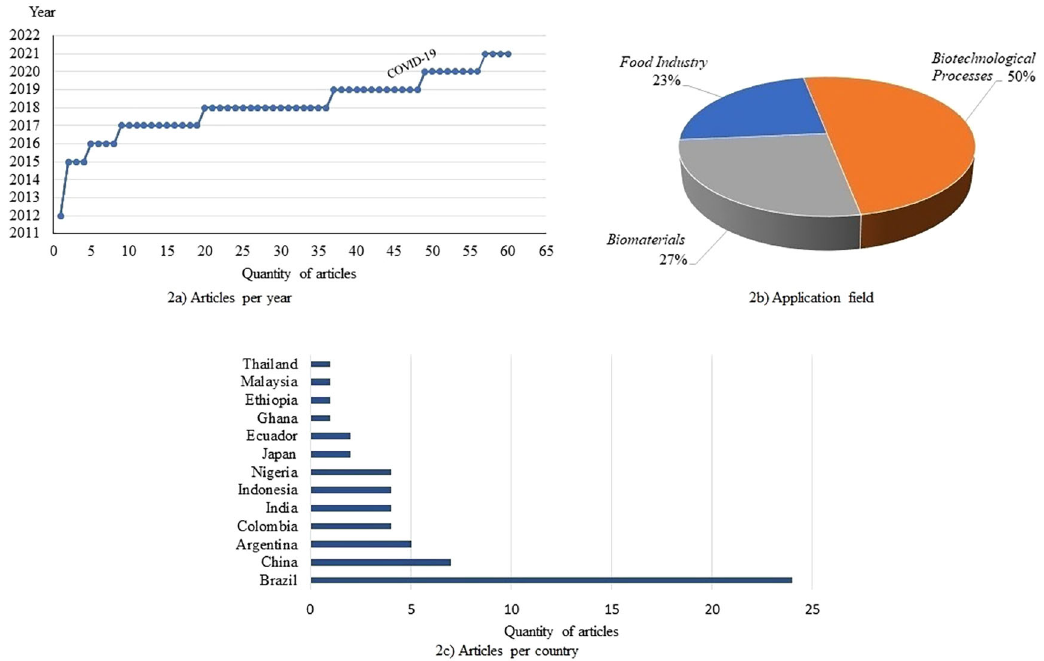
Figure 2. Study statistics on the use of cassava bagasse: a) Articles per year; b) Application field; c) Articles per